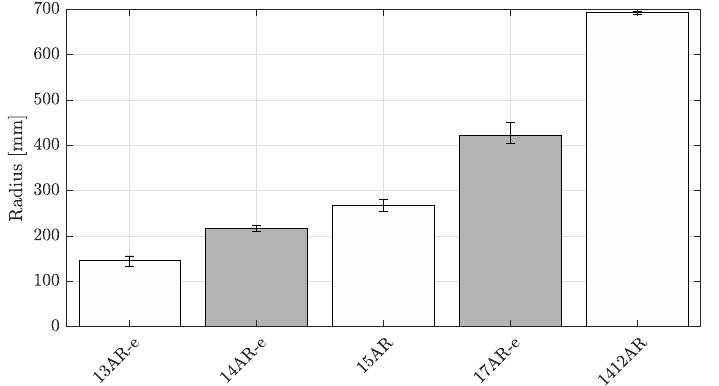
Figure 10. Variations in the layup and consequent specimen thicknesses result in significantly different radii of the asymmetric specimen.